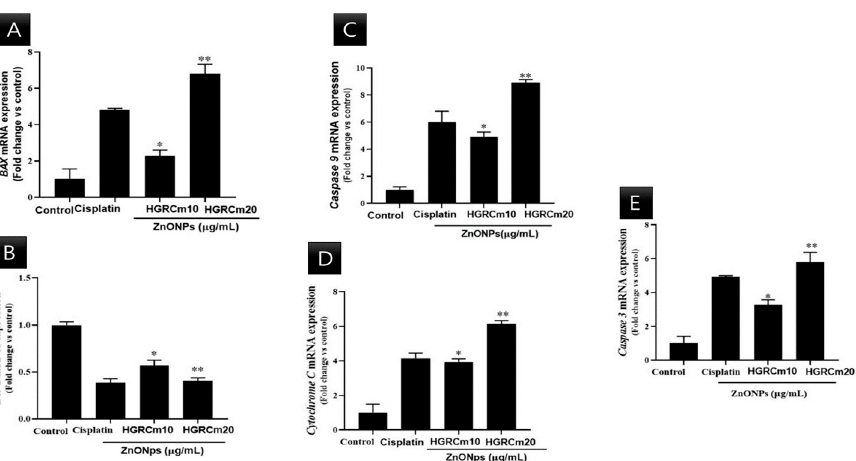
Figure 8. Effects of HGRCm-ZnO NPs on mRNA expression levels of apoptosis-related genes in A549 cells. Here, A549 cells were treated with HGRCm-ZnO NPs at 10 and 20 µg/mL for 24 h. Total RNA was then extracted, and transcript expression levels were determined by qPCR analysis using primers targeting ( A ) BAX , ( B ) Bcl-2 , ( C ) Caspase 9 , ( D ) Cytochrome C , and ( E ) Caspase 3 . Each bar represents the mean ± SE of duplicate samples from three independent experiments. * p < 0.01; ** p < 0.01 using Student’s t -test compared to the non-treated control).